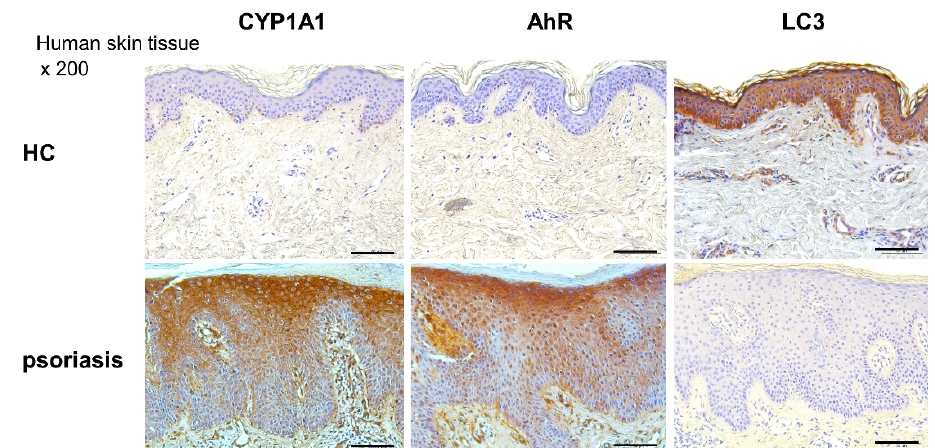
Figure 7. CYP1A1 and AhR expression was increased and LC3 decreased in psoriasis skin. Immunohistochemical staining of CYP1A1, AhR, and LC3 in human psoriasis lesion tissue and human healthy controls skin tissues. Bar = 50 µm. Data are representative of psoriasis ( n = 3) and healthy volunteers ( n = 3).